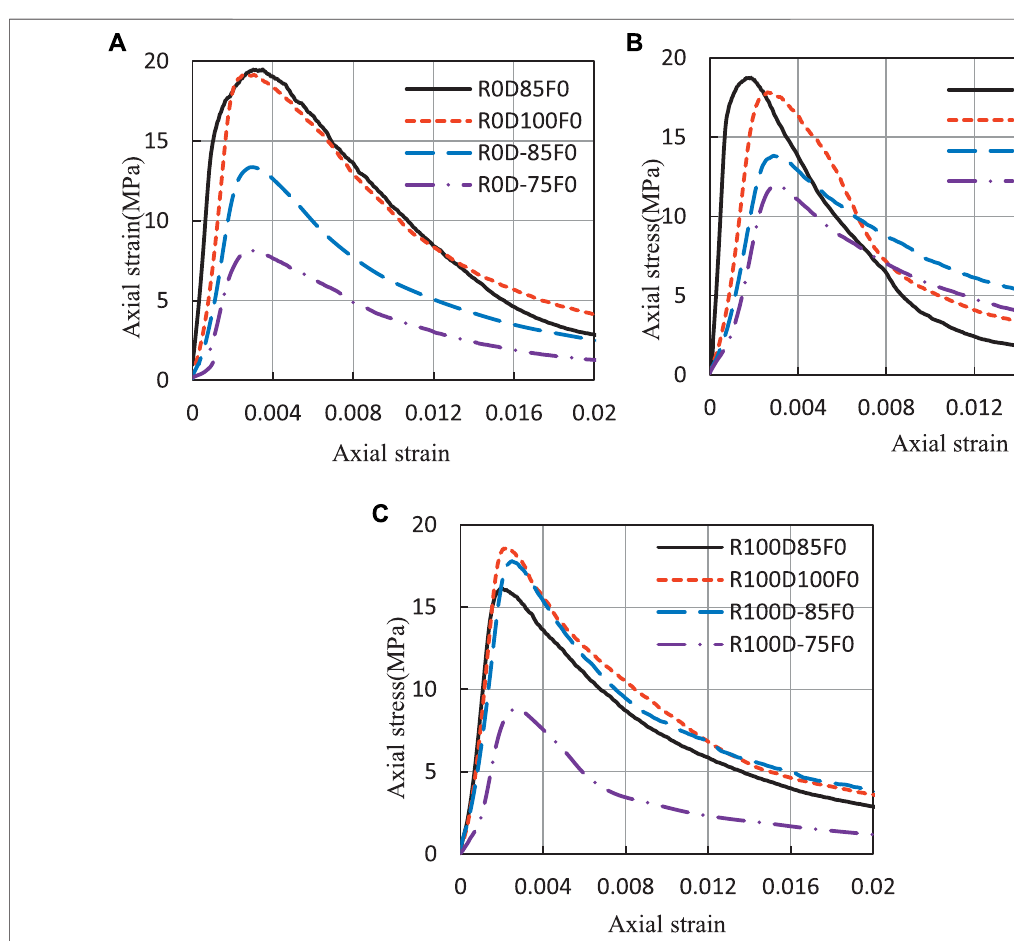
Figure 5 | Reloading stress-strain curves of specimens with different damage degree.